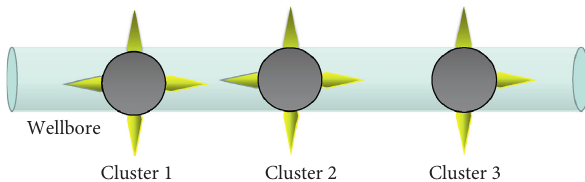
Figure 7: Perforation numbers in different